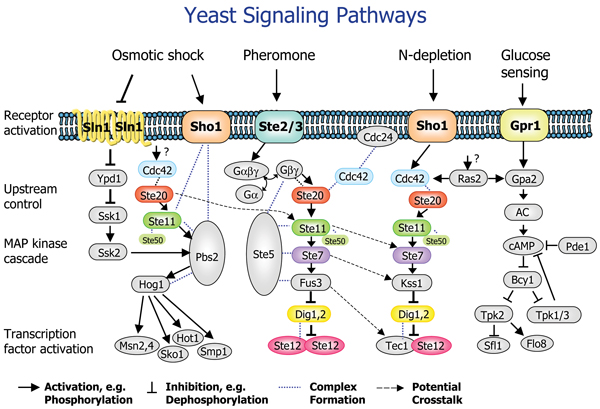
Signaling Pathways in Yeast. Overview of signaling pathways in the baker's yeast S. cerevisiae. From left to right: HOG pathway activated by osmotic shock, pheromone pathway activated by pheromones secreted by cells of the opposite mating type, pseudohyphal growth pathway stimulated by starvation conditions, and the glucose sensing pathway. In each pathway, the activated receptor activates a cascade of intracellular processes including complex formation, phosphorylation and dephosphorylation, and transport steps. Most of these pathways comprise a MAP kinase cascade and transcription factors that regulate the expression of target genes. Besides this, the signaling pathways can directly interact with cell cycle progression and adaptation of metabolism.